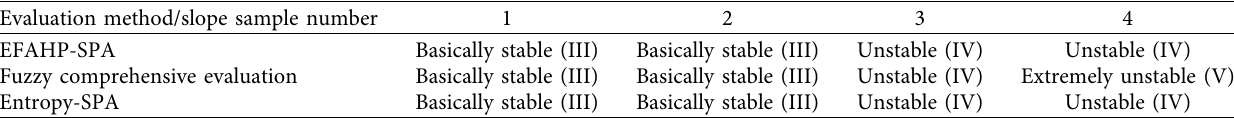
Table 11: Comparison table of slope stability evaluation results in open-pit mine.